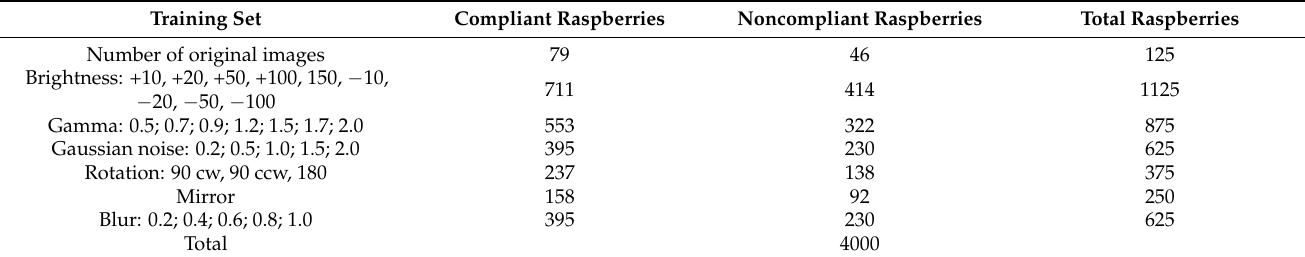
Figure 4. Image augmentation methods: ( a ) blur; ( b ) rotation; ( c ) gamma correction; ( d ) mirror effect; ( e ) brightness level; ( f ) noise. Table 1. Table with input